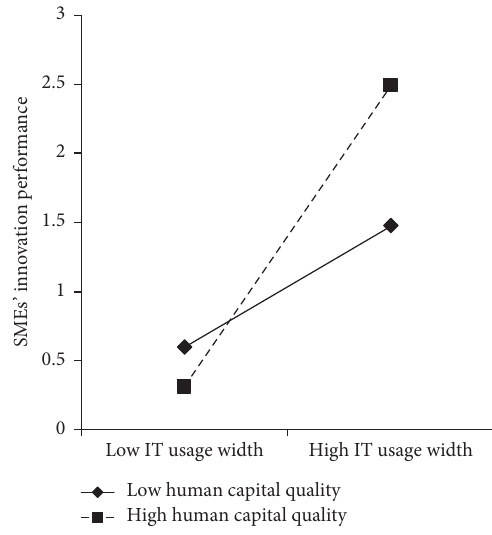
Figure 2: Moderating effect of human capital quality on the re- lationship between ITusage width and the innovation performance of